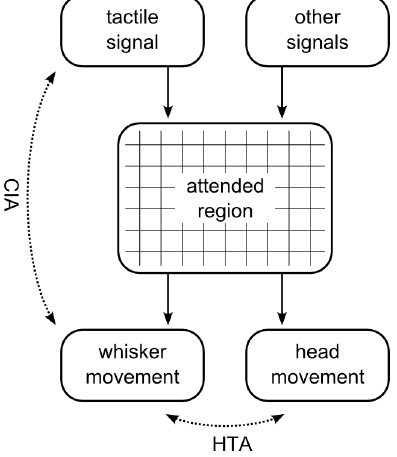
Figure 2. Model. Solid arrows indicate causal influences. Multiple influences affect the attended spatial region. One key influence will be whisker-environment contact (‘tactile signal’); others will include data from other sensory modalities and endogenous influences (‘other signals’). The ‘attended region’ drives both ‘whisker movement’ (rapidly and consistently) and ‘head movement’ (on a longer timescale, and only when this is not precluded by local geometry). Dotted lines show relationships that have been observed in animals. CIA is a correlation between contact and asymmetry in whisker movement. HTA is a correlation between turning of the head and asymmetry in whisker movement.